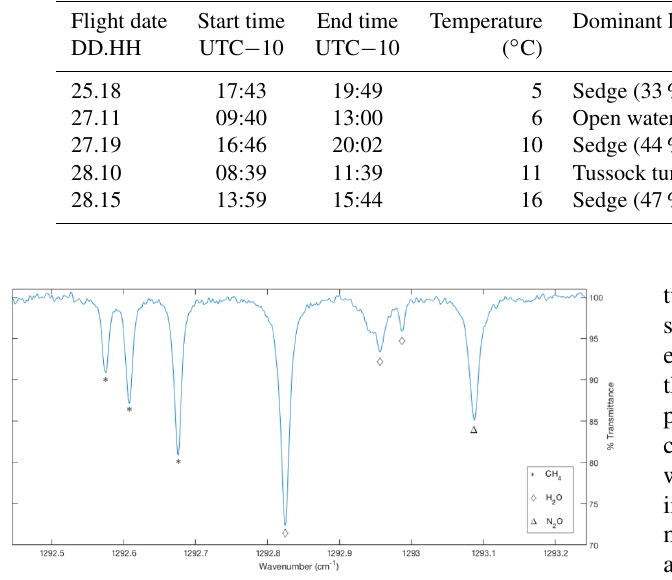
Figure 3. Sample 10Hz ICOS spectrum taken from Flight 28.10.